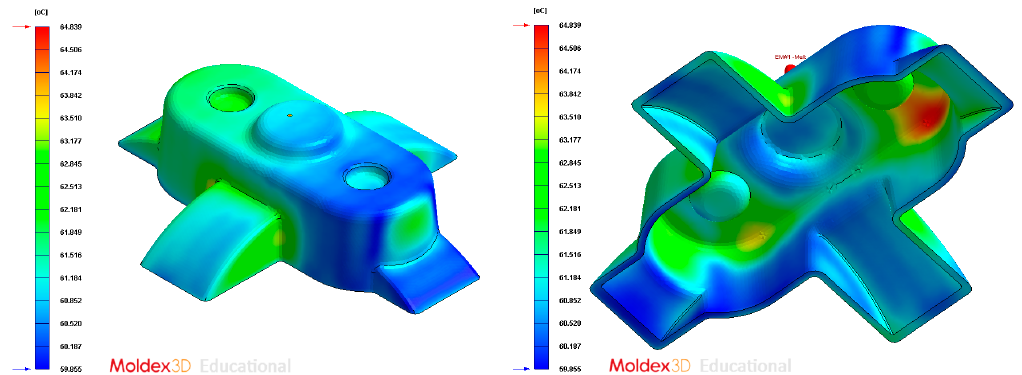
Figure 18. Average temperature (°C) at the surface of the plastic part after the cooling phase, Case A. Front view ( left ) and bottom view ( right ).